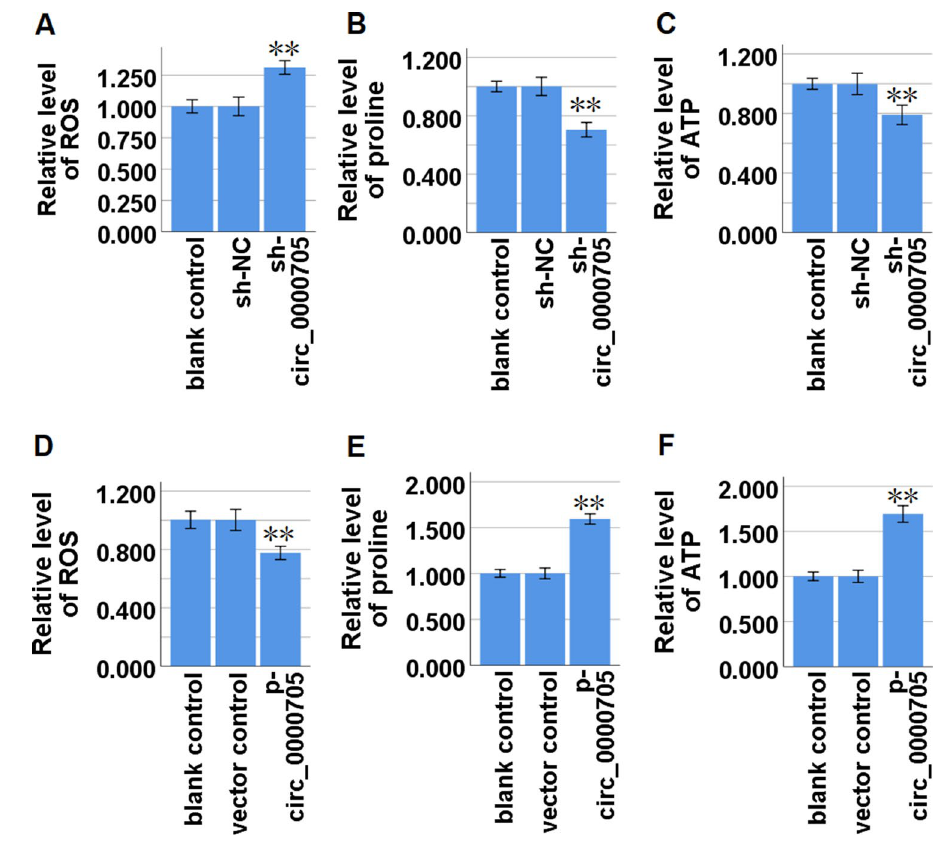
Fig. 3 Effect of circ_0000705 on proline metabolism in ESCC cells. A ROS level in KYSE150 cells with circ_0000705 knockdown was detected using a correspond- ing commercial kit. B Proline level in KYSE150 cells with circ_0000705 knockdown was detected using a cor- responding commercial kit. C ATP level in KYSE150